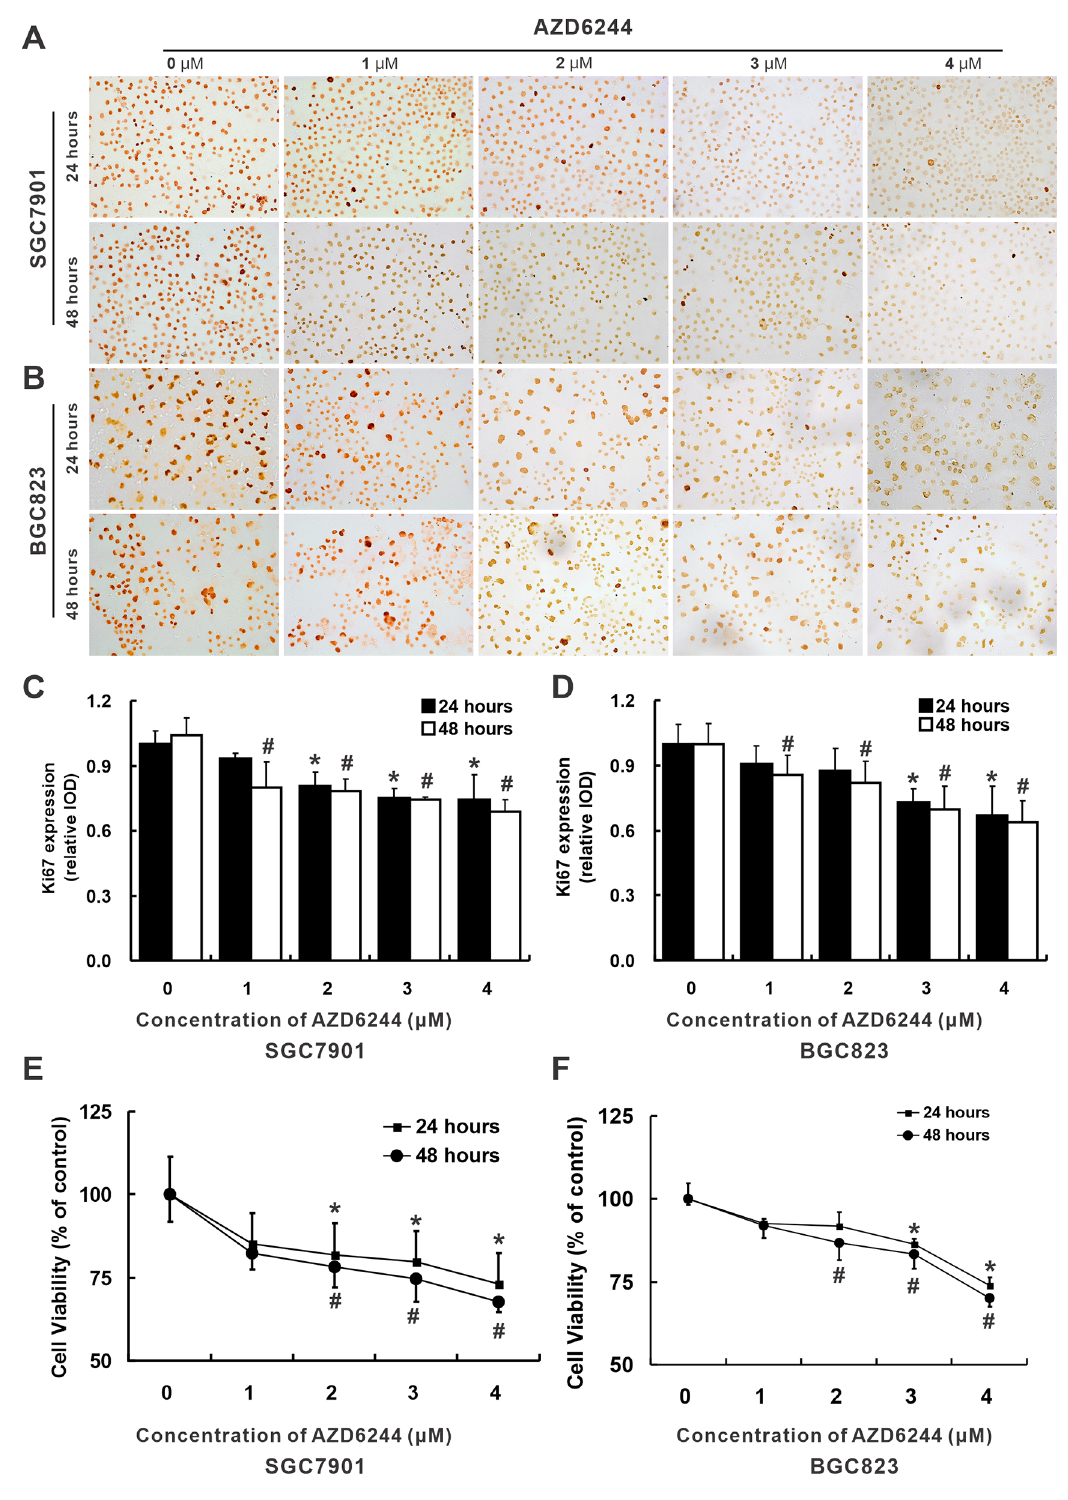
Figure 2. AZD6244 inhibits proliferation of gastric cancer cells. The proliferation of gastric cancer cell SGC7901 ( A ) and BGC823 ( B ) was determined by IHC of Ki67 (magnification: ~ × 400). Compared with vehicle treated SGC7901 cells, inhibition of proliferation was observed in cells treatment with high concentration of AZD6244 (2, 3 and 4 μM) for 24 hours and all given concentration of AZD6244 (1, 2, 3 and 4 μM) for 48 hours ( C ). Compared with vehicle treated BGC823 cells, proliferation was suppressed by treatment with high concentration of AZD6244 (3 and 4 μM) for 24 hours and all given concentration of AZD6244 for 48 hours ( D ). Meanwhile, the CCK-8 assay was carried out to evaluation of cell viability. Relatively high concentration of AZD6244 (2, 3 and 4 μM) was able to suppress cell viability of SGC7901 for 24 and 48 hours. Similarly, reduction of cell viability was observed in cells treatment with high concentration of AZD6244 (3 and 4 μM) for 24 and 48 hours. Furthermore, treatment with AZD6244 at the concentration of 2 μM for 48 hours was also able to inhibit cell viability. * p < 0.05 vs . vehicle treated cells for 24 hours; # p < 0.05 vs . vehicle treated cells for 48